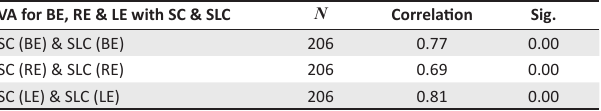
FIGURE 3: A Bland − Altman graph showing the agreement between scores of visual acuities (in min) right eyes obtained with a Snellen chart and Spectrum LogMAR